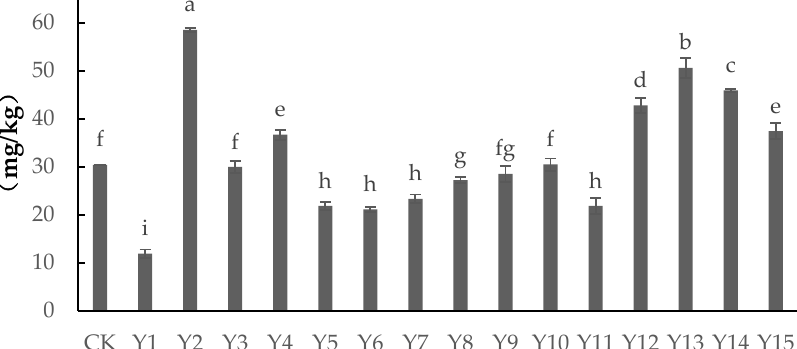
Figure 4. The content of polyphenol in Camellia oil under different treatments. Note: Data indicate mean ± SE ( n = 3). Different letters indicate significant differences ( p < 0.05) between different treatments.